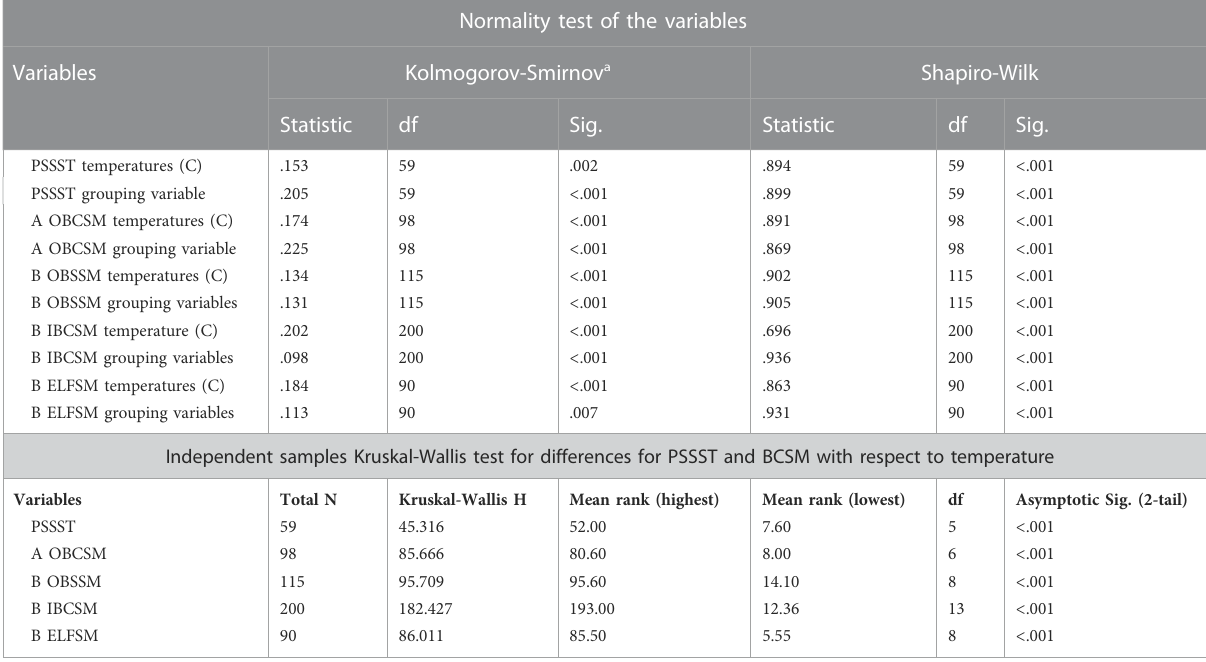
TABLE 5 Normality test of the variables and independent samples Kruskal-Wallis Test for differences for PSSST and BCSM with respect to